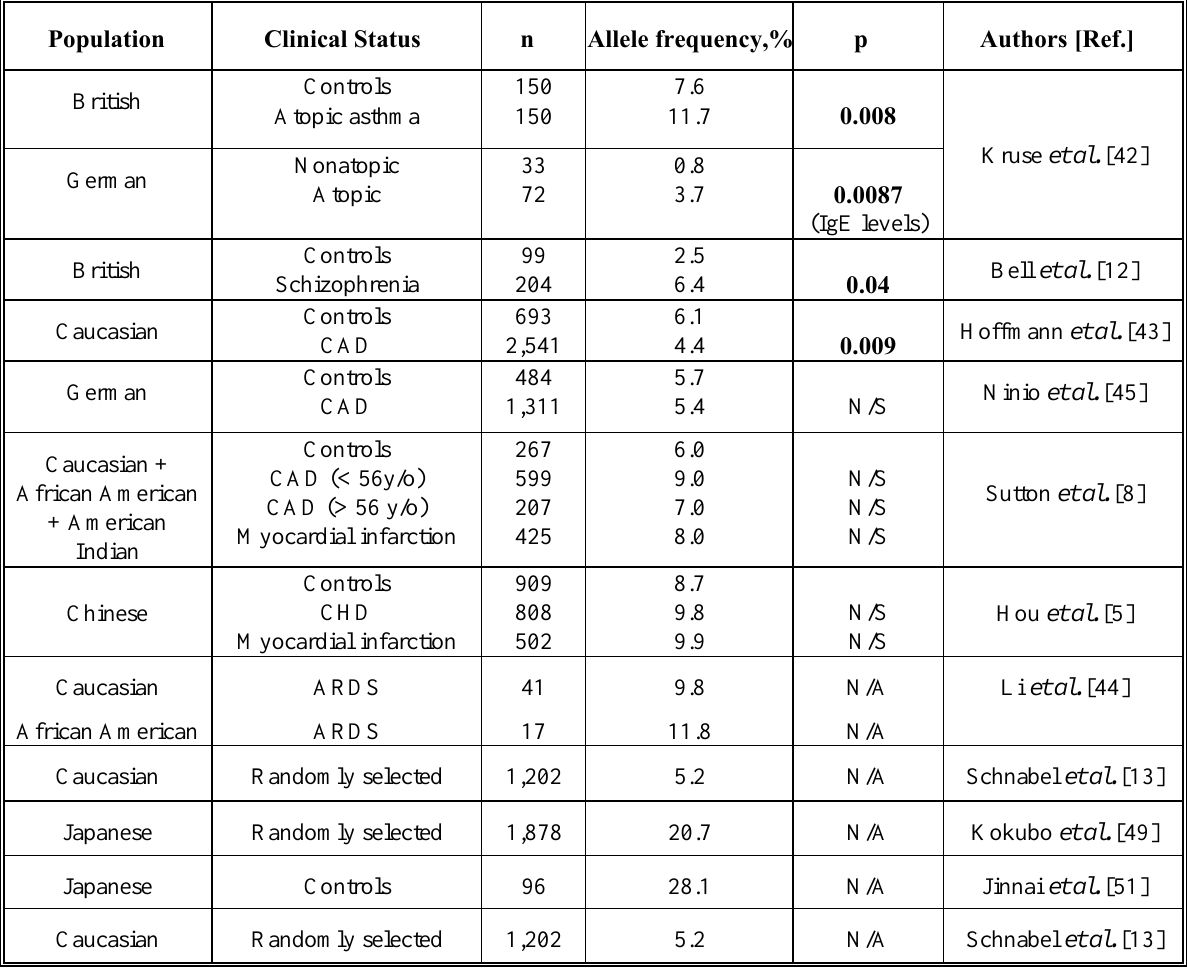
Caucasian Randomly selected This Table summarizes results from studies in various human populations genotyped for the I198T polymorphism. The incidence of rs1805018 is reported in terms of the percentage with which the allele was represented in healthy and diseased subjects. The “n” column refers to the number of participants in each study category and includes subjects harboring 0-1-2 polymorphic alleles. The “p” column depicts whether statistically significant differences were found in polymorphism incidence in control and diseased populations, where available/appropriate. ARDS: acute respiratory distress syndrome; CAD: coronary artery disease; CHD: coronary heart disease; N/A: not applicable; N/S: not statistically